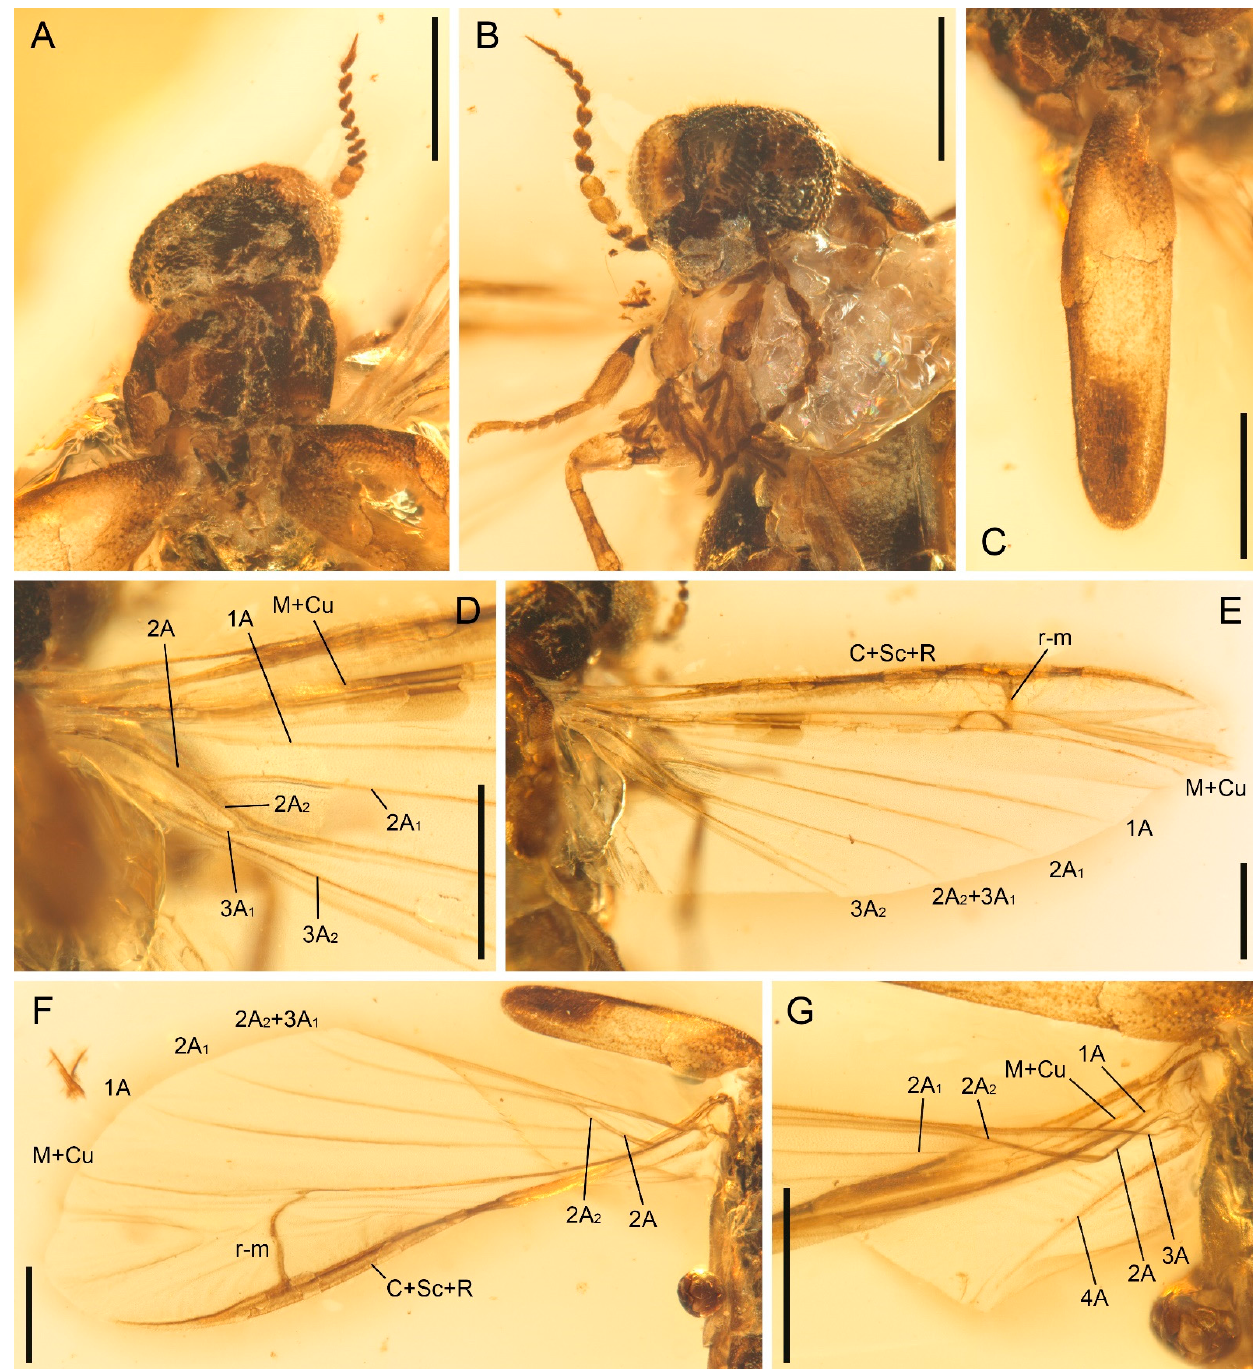
Figure 2. Details of Cretoquadratus fossilis (Yamamoto) comb. nov. , NIGP180657, under incident light. ( A ) Head and prothorax, dorsal view. ( B ) Head, anterior view. ( C ) Elytron, dorsal view. ( D , E ) Right hind wing. ( F , G ) Left hind wing. Scale bars: 500 μ m.